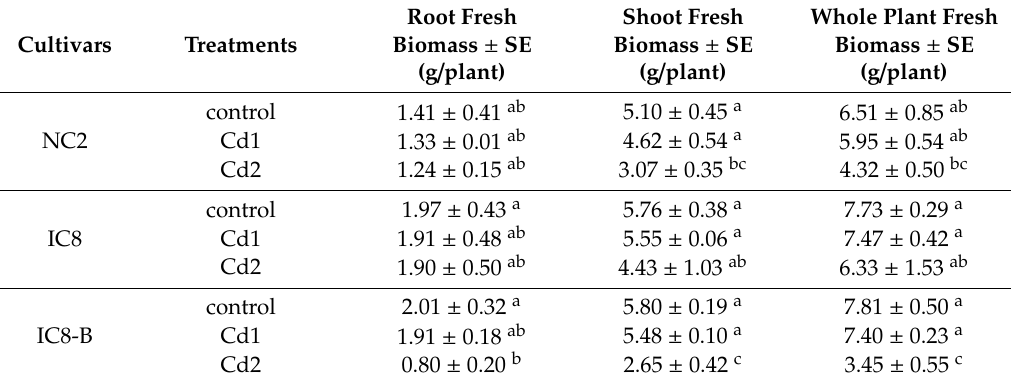
Table 2. Fresh biomasses of the roots, shoots and total plant of chickpea seedlings grown in a nutrient medium under Cd stress at the rate of 0 µ M (control), 25 µ M (Cd1) and 50 µ M (Cd2) with mean values ± SE, ( n =